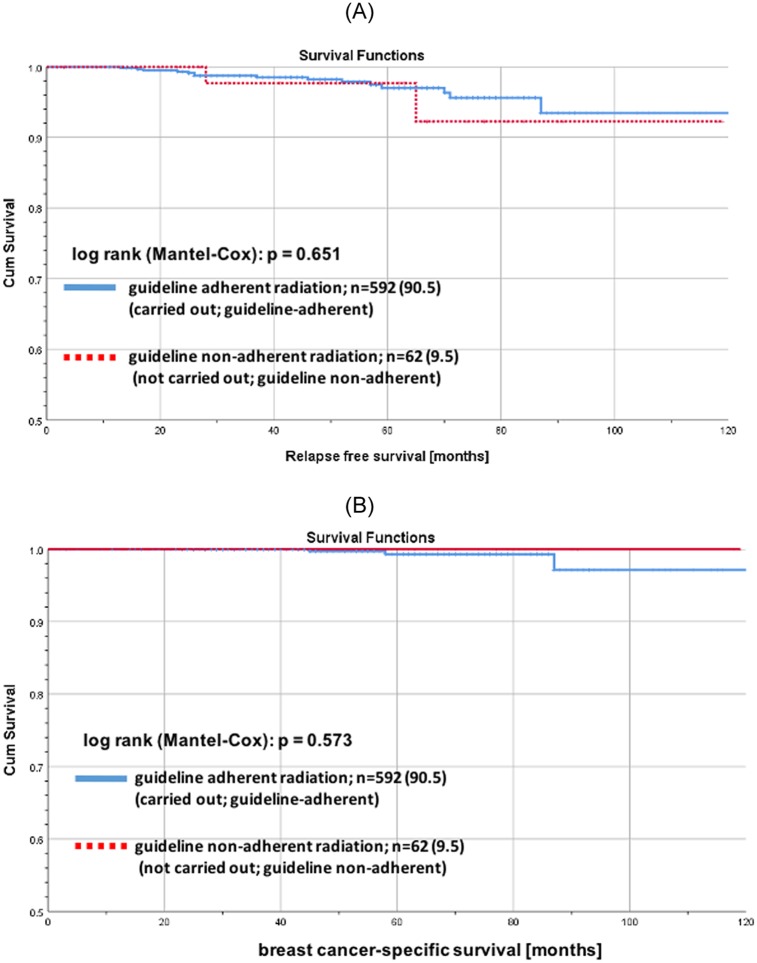
Recurrence free and tumor-associated overall survival for early breast cancer patients aged ≥ 70 years stratified by guideline adherent radiotherapy.(A) Kaplan-Meier curves of recurrence free survival for low risk early breast cancer patients aged 70 years and older with guideline adherent BCS stratified by guideline adherent RT. Low risk: luminal A and T1/T2 and node-negative. (B): Kaplan-Meier curves of tumor-associated overall survival for low-risk early breast cancer patients aged 70 years and older with guideline adherent BCS stratified by guideline adherent RT.